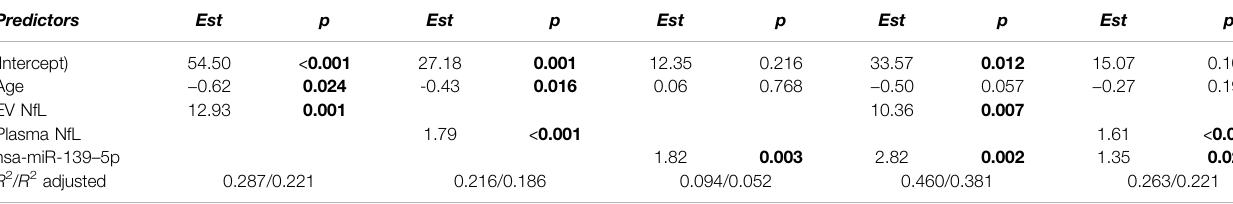
TABLE 3 | Linear Regression Models for PCL-5